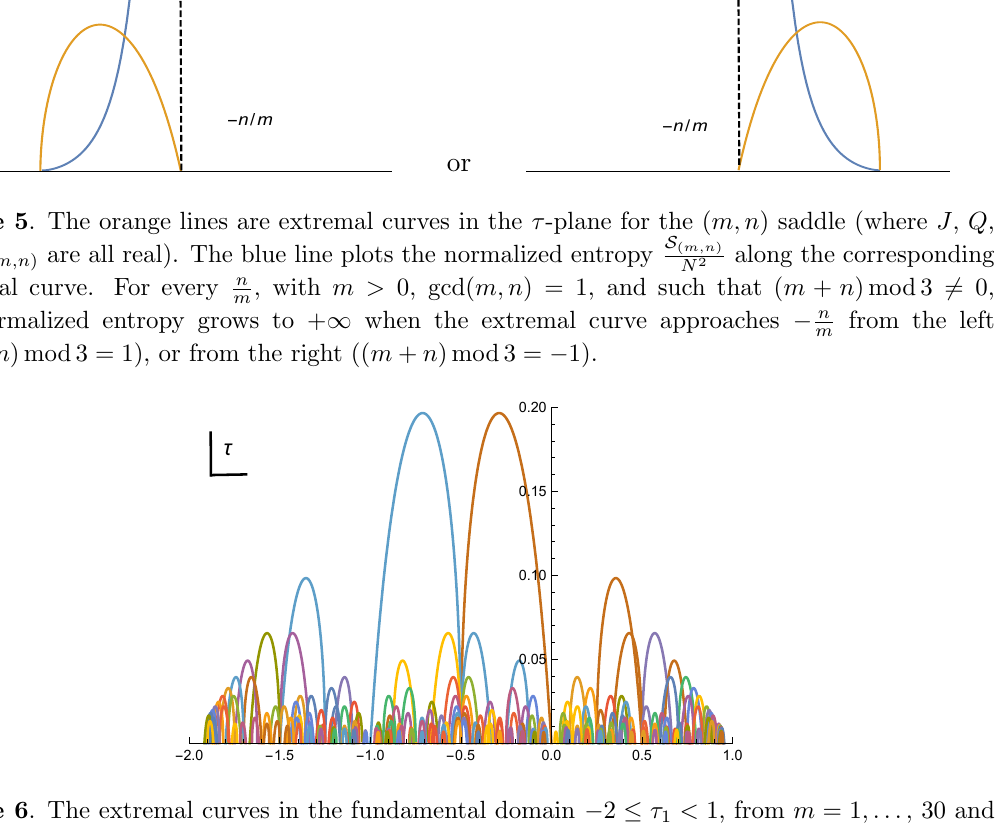
Figure 6 . The extremal curves in the fundamental domain (cid:0) 2 (cid:20) (cid:28) 1 < 1, from m = 1 ; : : : ; 30 and n = (cid:0) 30 ; : : : ;